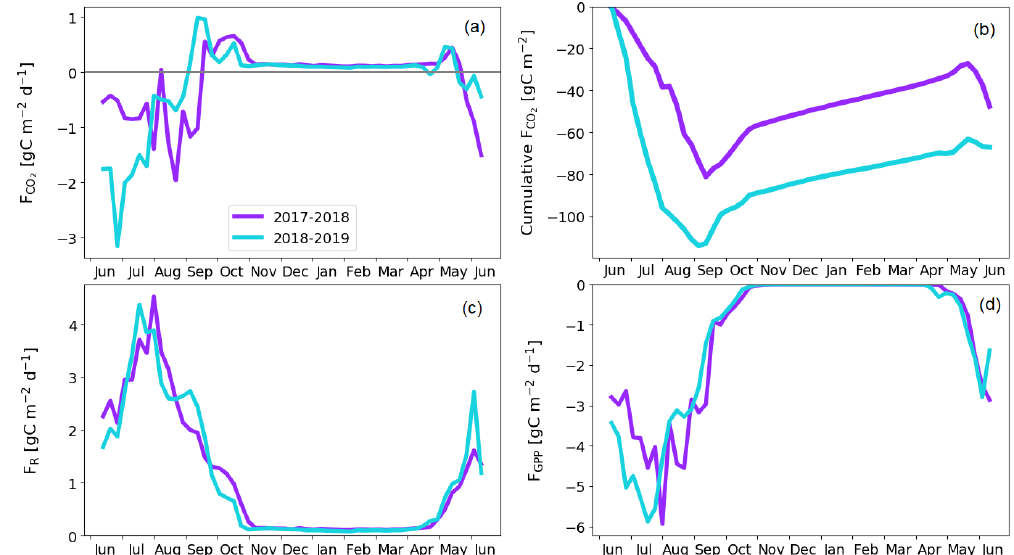
Figure 12. Sparsely treed pine bog gap-filled fluxes. Weekly averaged CO 2 flux (a) and cumulative CO 2 flux (b) . Weekly averaged ER (c) and GPP (d) flux.